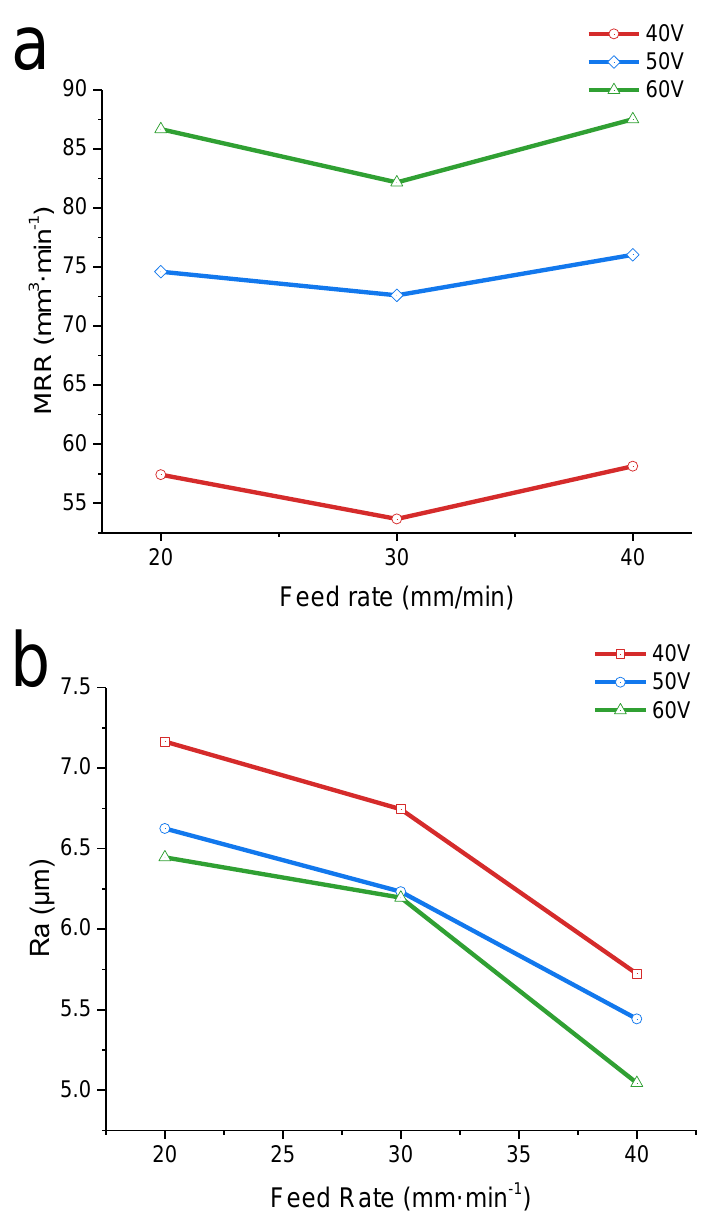
Figure 7. MRR and Ra at different machining voltages. ( a ) Different MRRs at applied voltage = 40 V (red), 50 V (blue), and 60 V (green). ( b ) Different Ra at applied voltage = 40 V (red), 50 V (blue), and 60 V (green). The effect of the feed speed on the MRR is not apparent, while surface roughness is significantly affected by the feed rate.